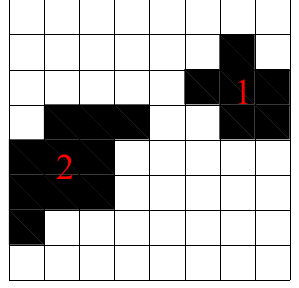
Figure 5. Connected regions in an image.